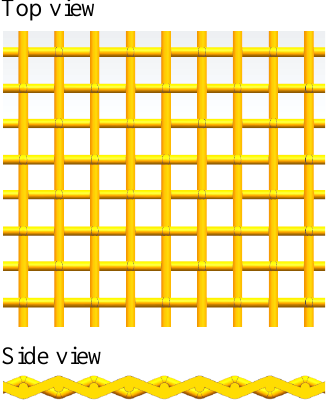
Figure 1. Schematic of the wire mesh structure. The diameter of the wire is 140 µ m.